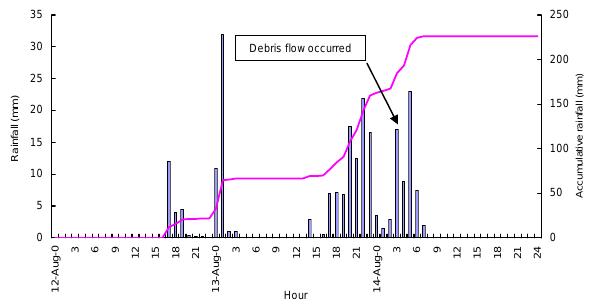
Fig. 11. Loose deposits induced by the 2008 Wenchuan Earthquake in the Hongchun gully, with an increase of loose material of about 150×10 4 m 3 . H is the abbreviations of landslides.